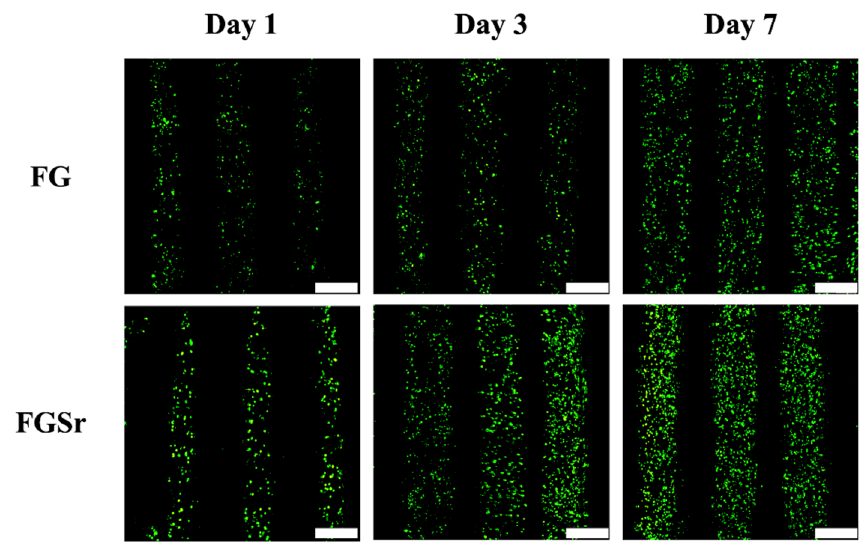
Figure 9. The image of live/dead assay results of WJMSC-laden FG and FGSr scaffolds for different time-points. Scale bar: 400 μ m.